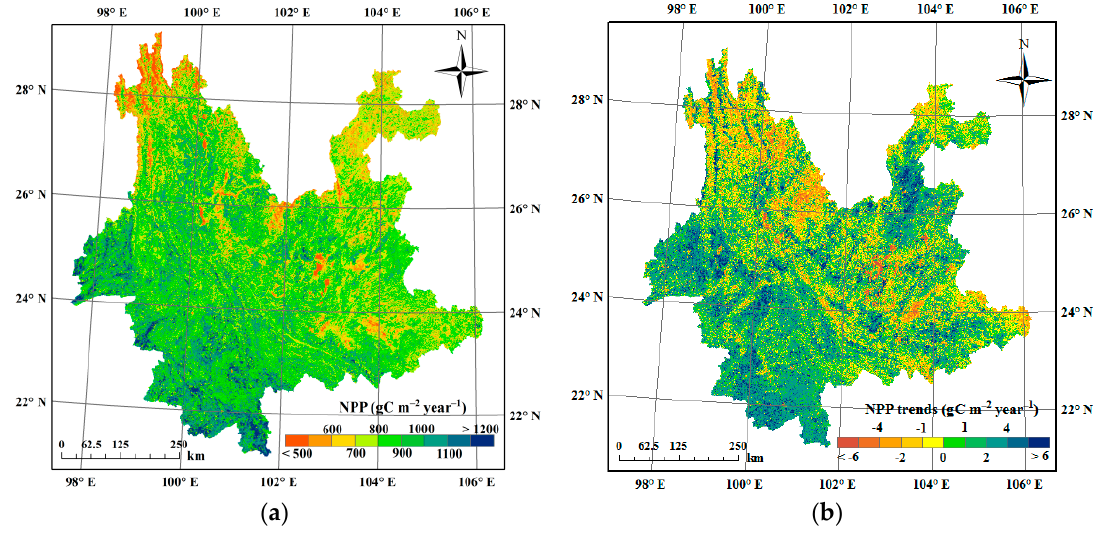
Figure 7. The spatial patterns of: ( a ) mean annual NPP over the past 33 years; and ( b ) annual NPP trends (the slope of NPP inter-annual variation).